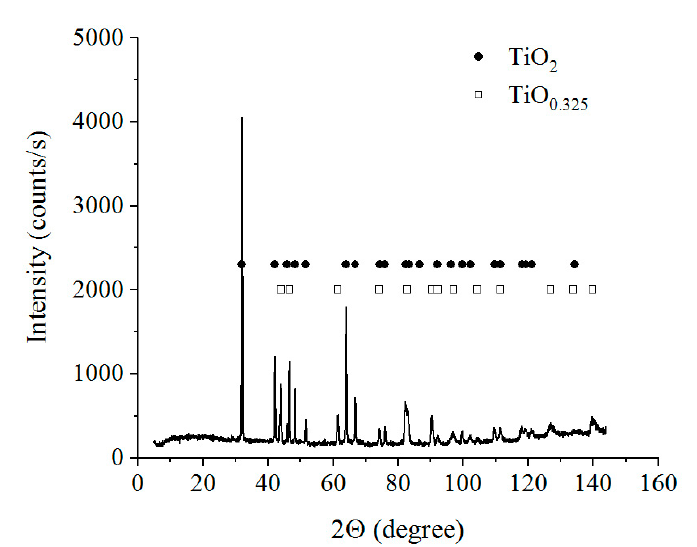
Figure 4. X-ray diffraction patterns of the CP-Ti surface layer after anodic PENC at 900 °C.